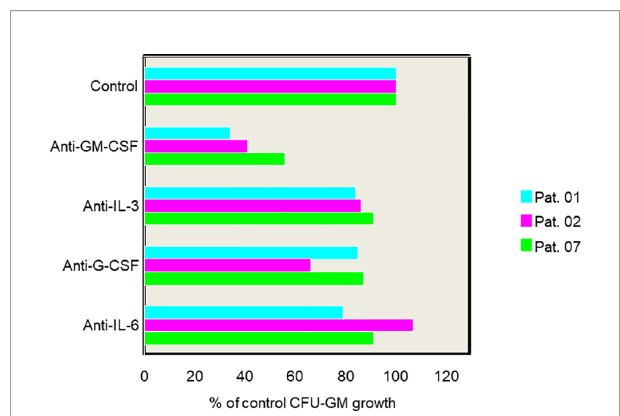
FIGURE 1 | Effect of anticytokine antibodies on spontaneous growth of CMML cells in 3 patients. PB MNC were cultured with medium alone or with antibodies against GM-CSF, G-CSF, IL-3, or IL-6, respectively. Data show a marked inhibition of spontaneous CFU-GM growth in the presence of anti- GM-CSF antibodies in all 3 patients indicating that autonomous colony formation is a GM-CSF dependent in vitro phenomenon [adapted from Geissler, K., et al., J Exp Med 1996